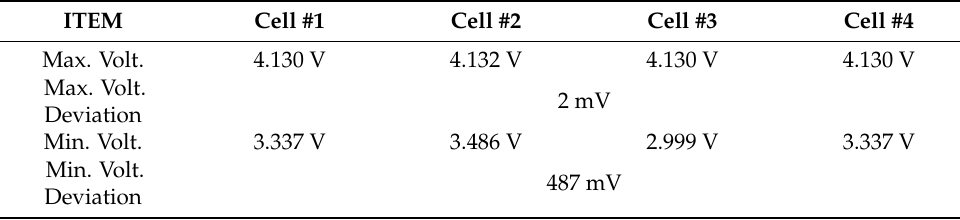
Table 6. Comparison of batteries with the proposed cell-balancing method applied.